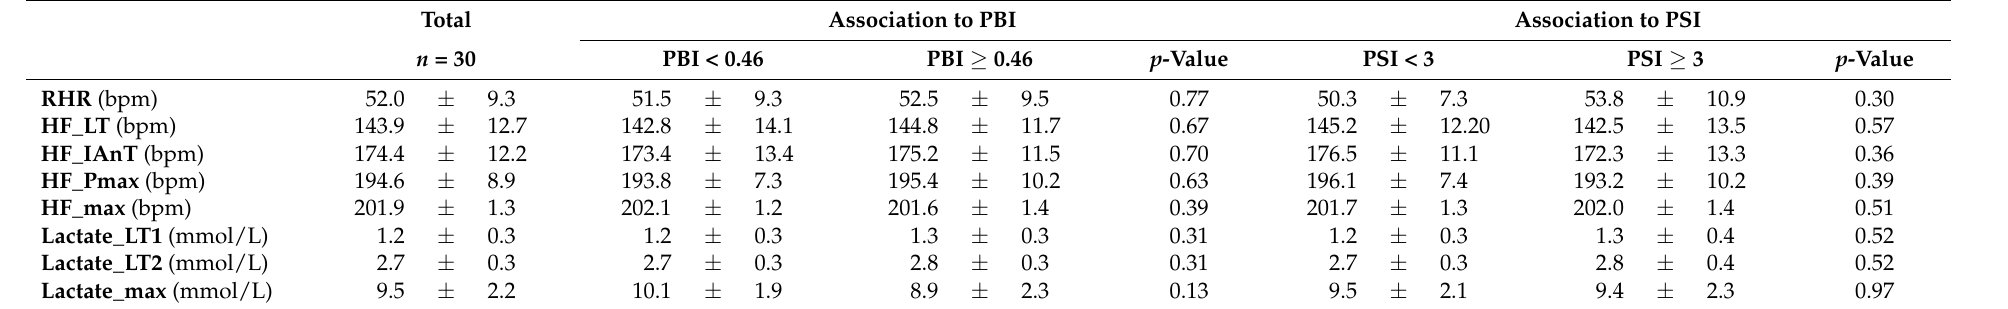
Table 5. Performance test parameters, heart frequencies, and lactate values during incremental exercise test and their association with periodontal health (PBI and PSI).